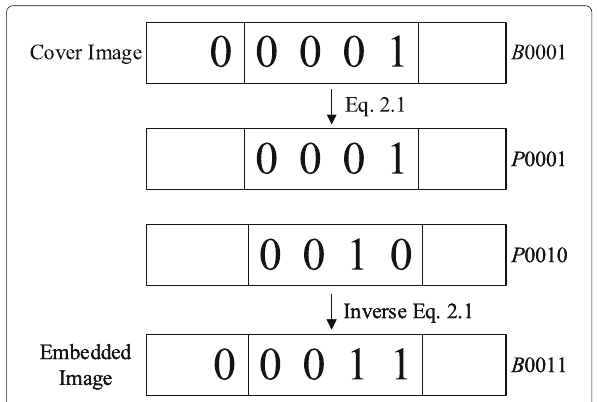
Fig. 2 An example of P 0001 and P 0010 which satisfies Condition